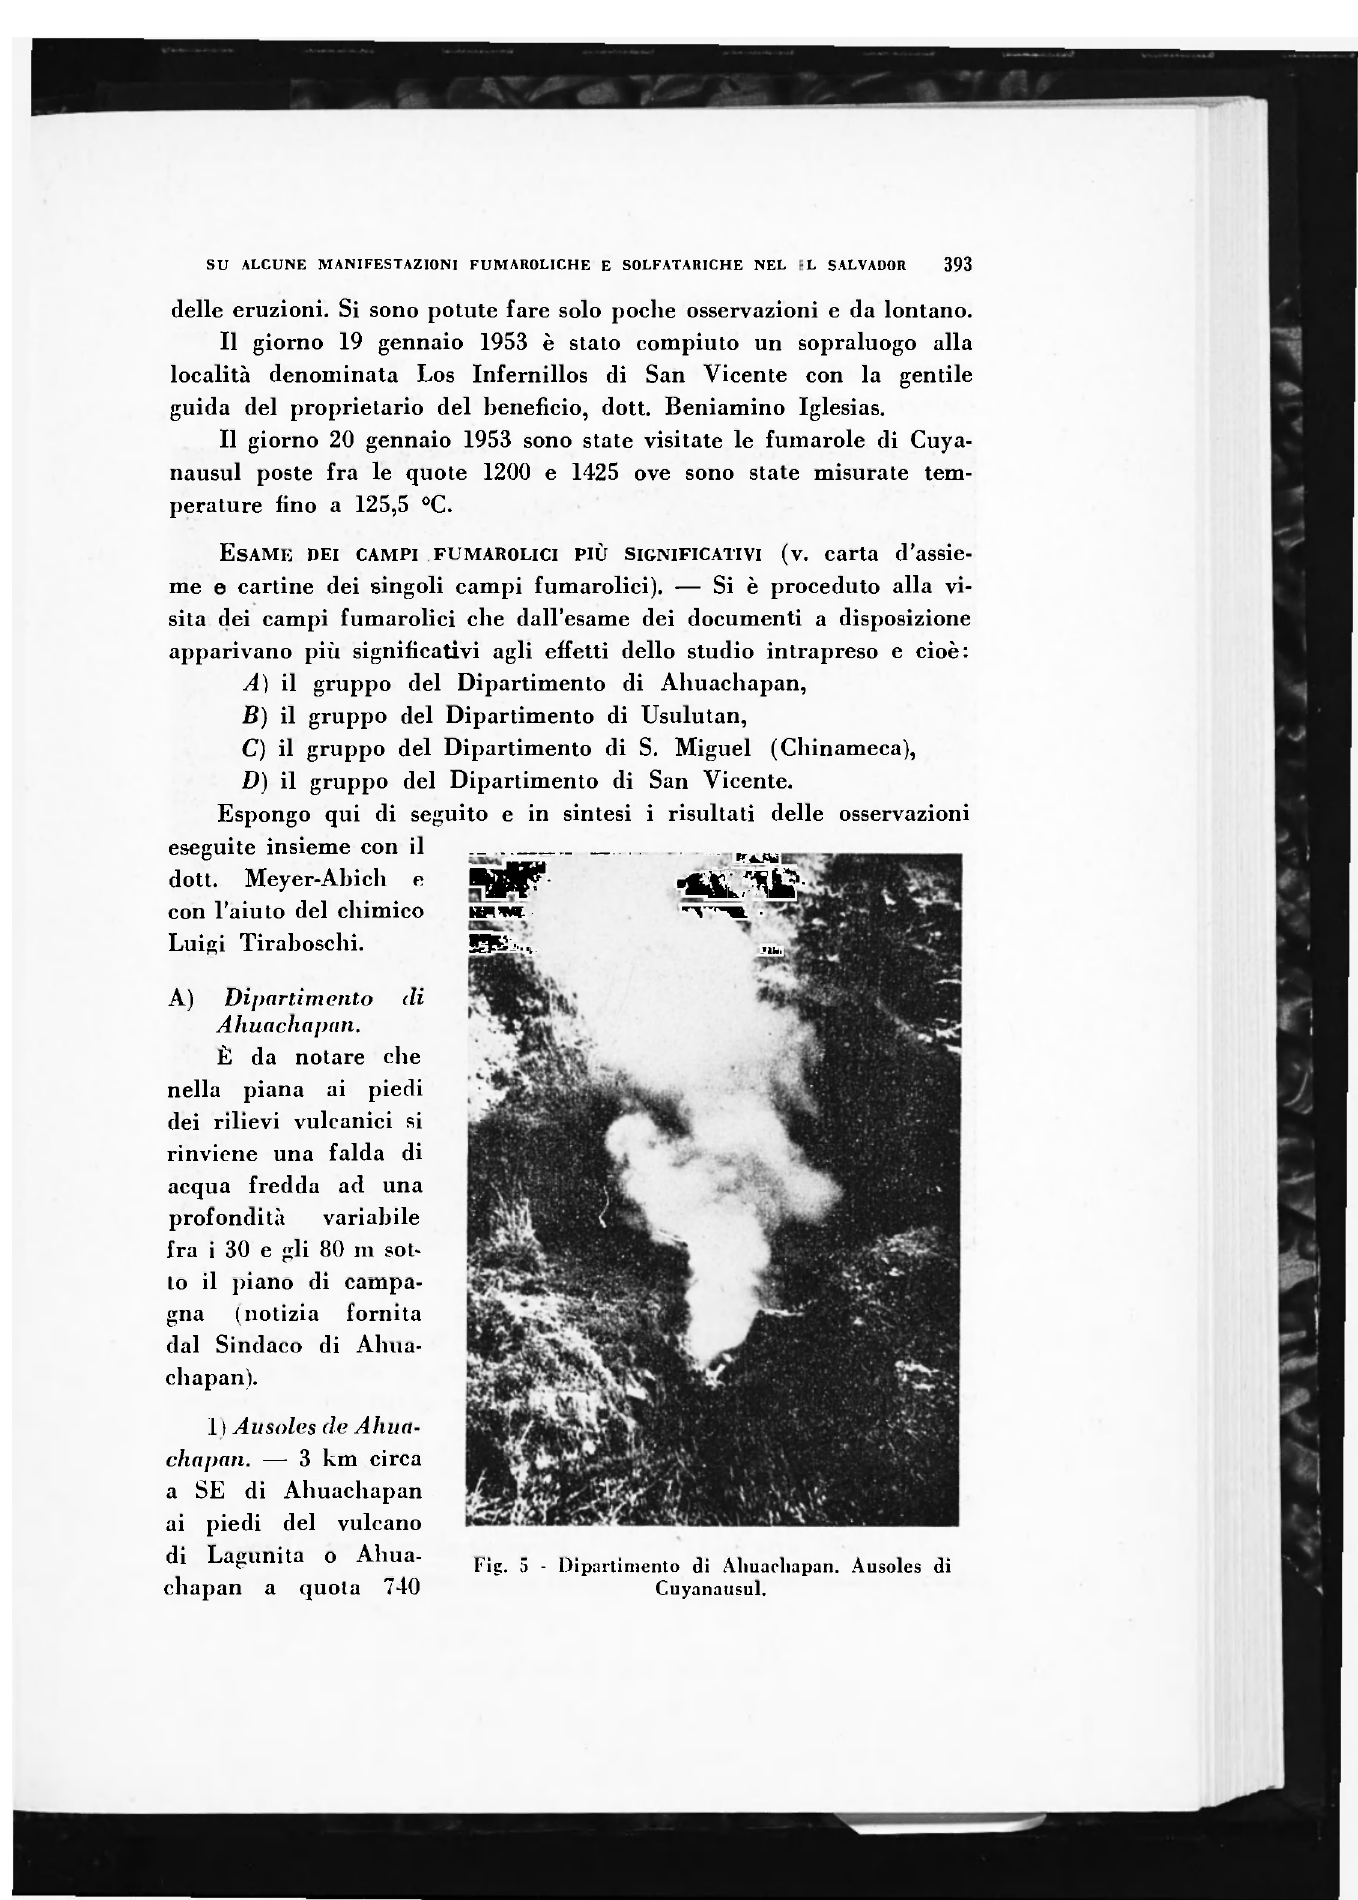
Fig. 5 - Dipartimento di Ahuachapan. Ausoles di